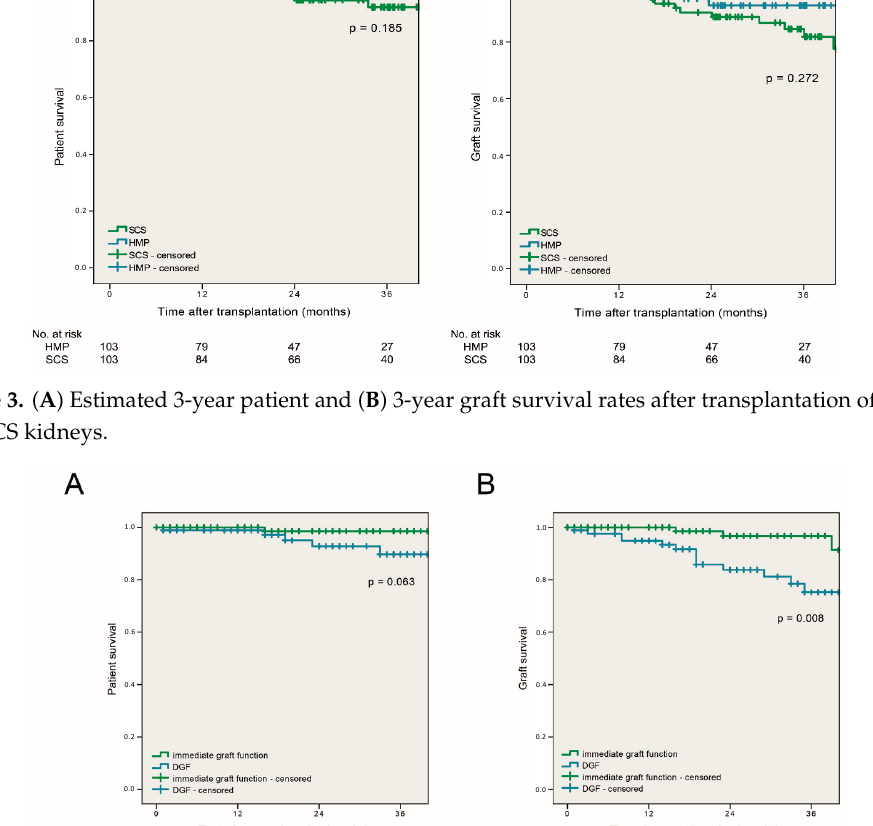
Figure 4. ( A ) Estimated 3-year patient and ( B ) 3-year graft survival rates of patients stratified for immediate graft function and delayed graft function.